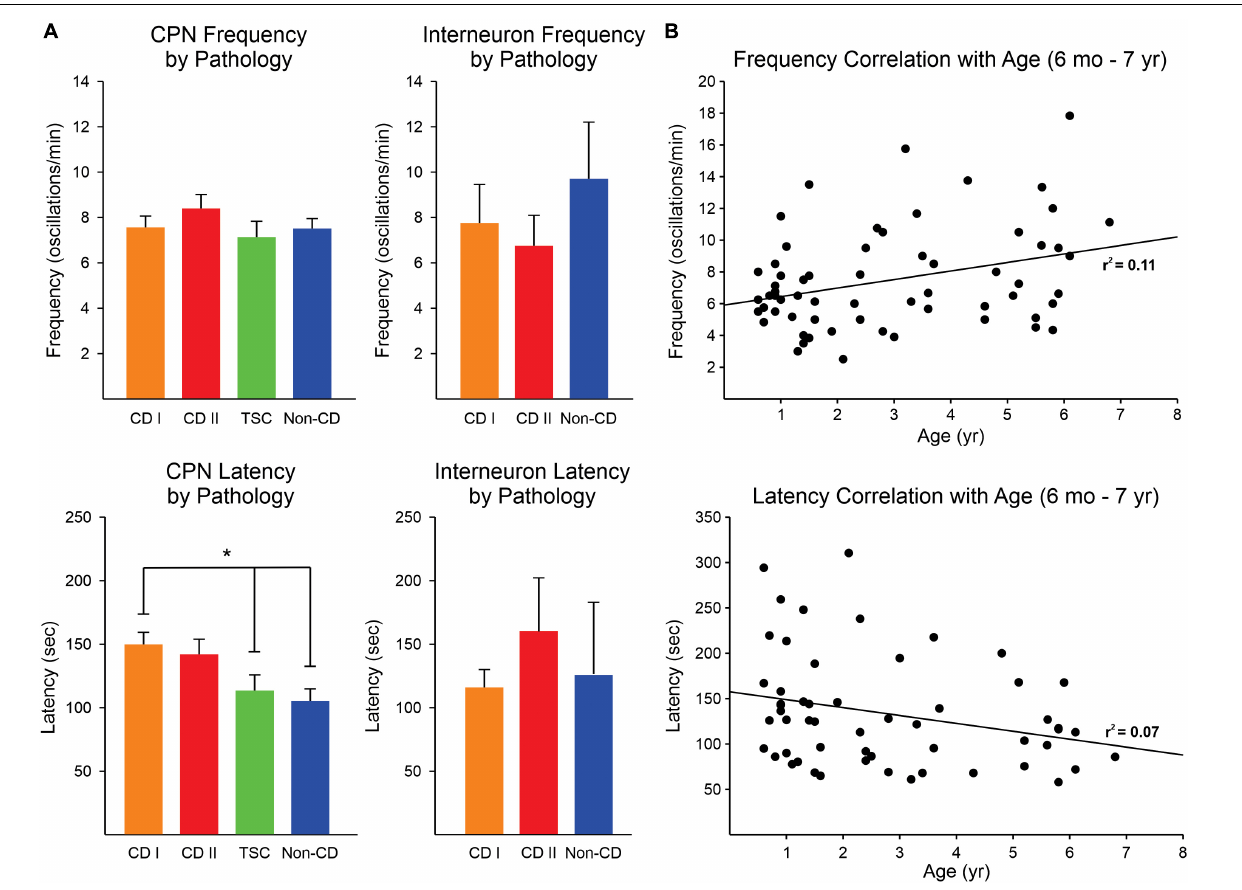
FIGURE 3 | Frequency and latency of 4-AP oscillations by pathology. (A) No difference was observed in the frequency of 4-AP oscillations in CPNs and interneurons among pathologies, only a trend for higher frequency of oscillations in CPNs in the CD type II group (upper panels). The latency for the first occurrence of 4-AP oscillations in CPNs was significantly increased in CD type 1 cases compared with non-CD and TSC cases (lower panels) ( p < 0.05, one-way ANOVA with Bonferroni correction). CD type II cases also had a strong trend for longer latencies. No difference in latency among groups occurred in interneurons. In TSC, only one interneuron was recorded, so this group was not included in the graphs. (B) Correlations between frequency and latency of 4-AP oscillations with age. There was a minimal, non-significant correlation between age and frequency/latency of 4-AP oscillations. * p <